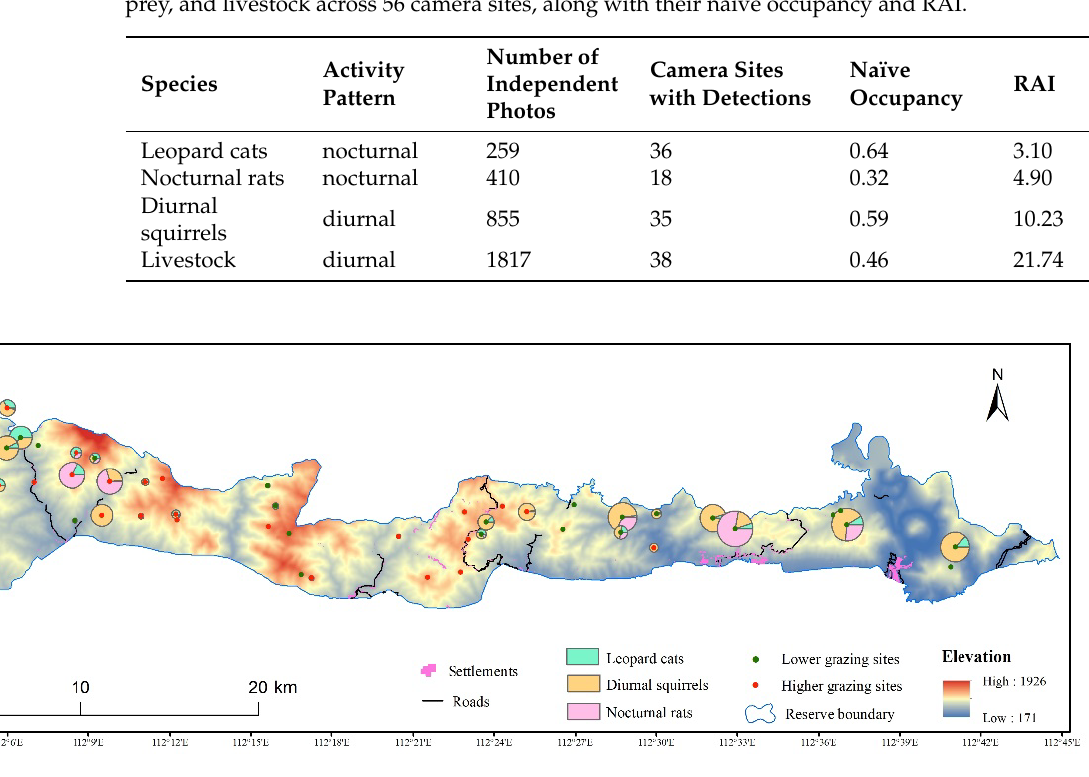
Figure 3. The composition of relative abundance index for leopard cats and their potential prey in higher and lower grazing sites in the Taihang Mountain Macaque National Nature Reserve, Jiyuan city, Henan province, China.